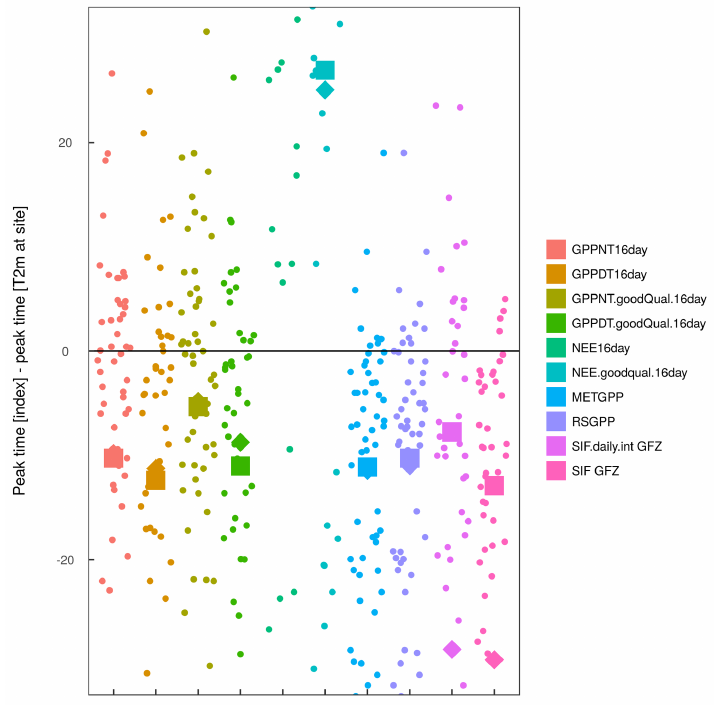
Figure A9. Difference in peak timing in the different indicators to site-level temperature over years at selected FLUXNET sites. Diamonds represent the average peak lag across all years and sites, while squares indicate the average peak time across years and sites, excluding NO-Adv, DK-ZaH and DK-ZaF (where either no seasonality in SIF or strong issues between different partitioning methods are apparent).